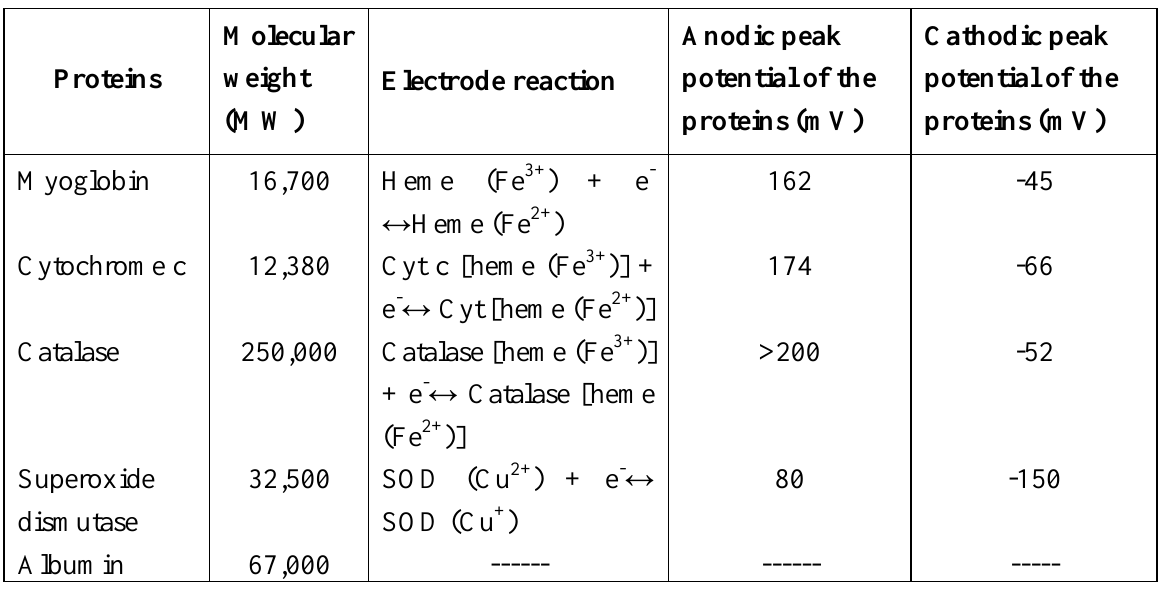
Table 1. Electrochemical behaviors of some proteins on a